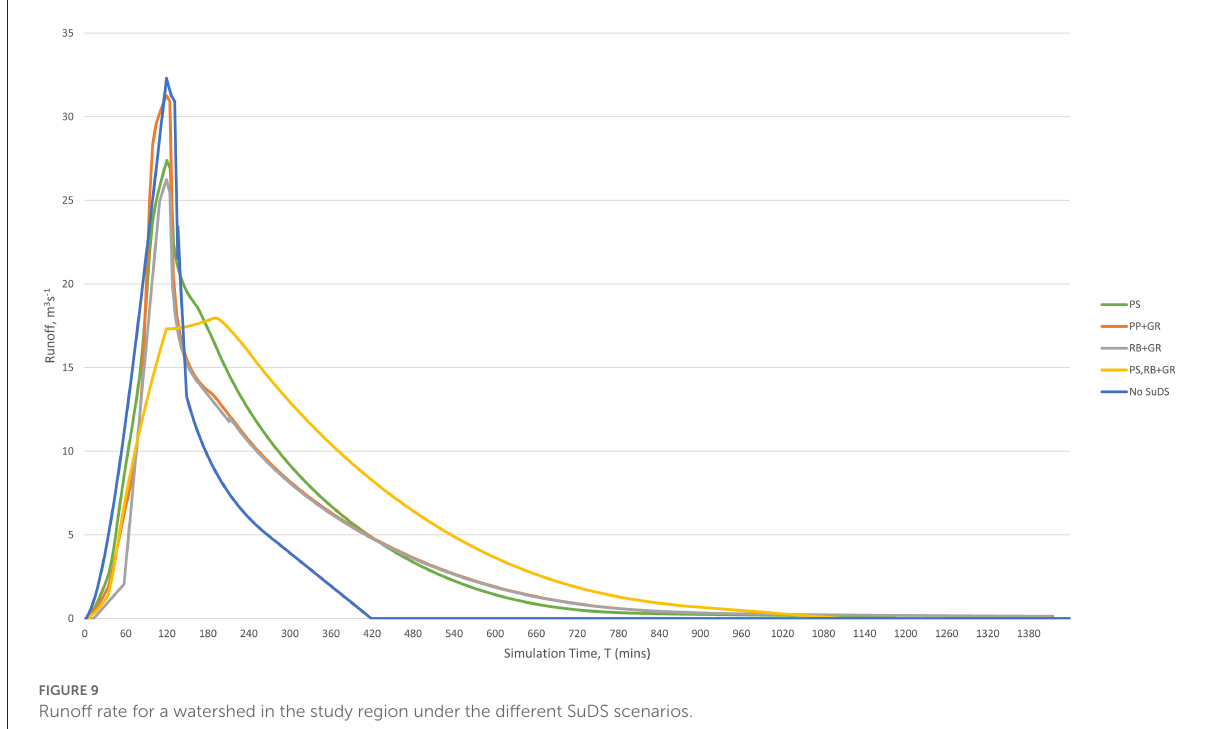
FIGURE9 Runoff rate for a watershed in the study region under the different SuDS scenarios.